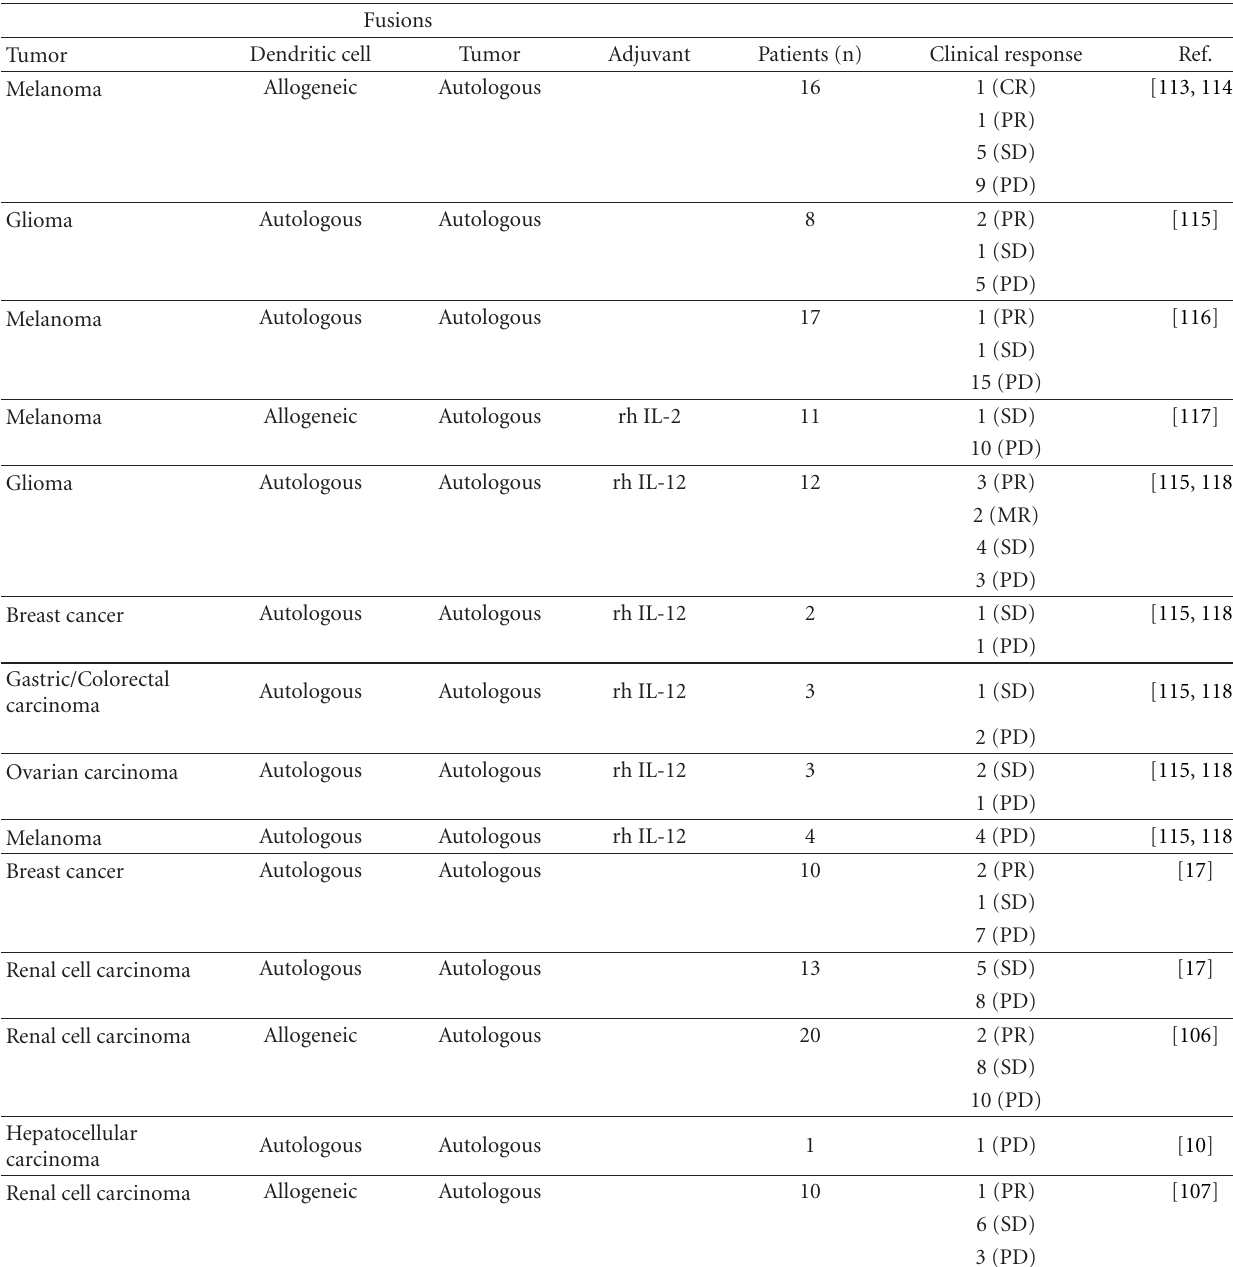
Table 1: Asessment of the fusions